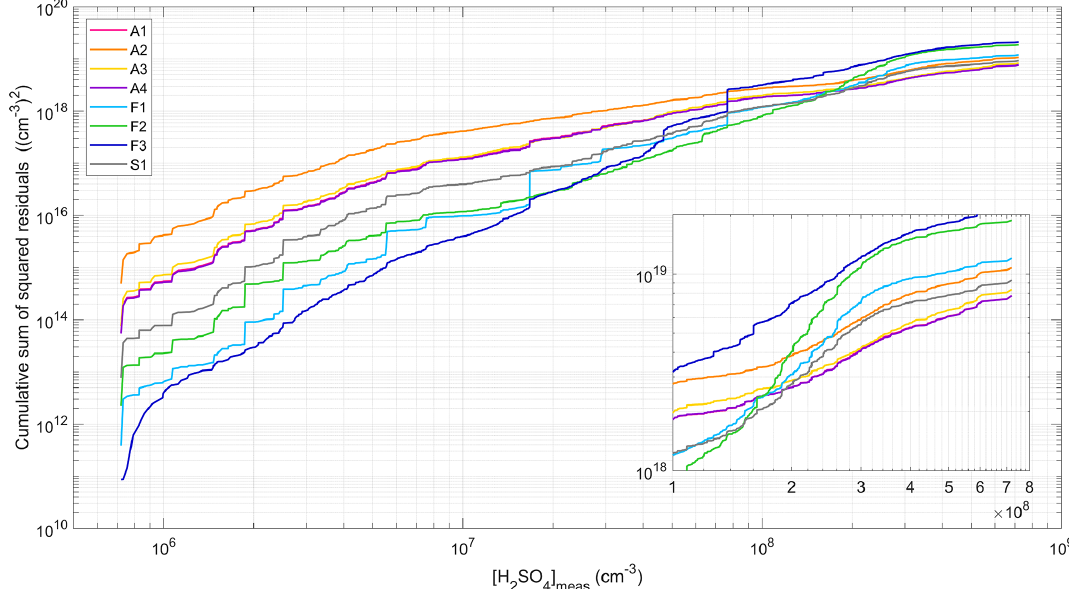
Figure 4. Cumulative sum of squared residuals associated with the different proxies. The insert presents a zoomed in section of the results obtained for [H 2 SO 4 ] > 1 × 10 8 cm − 3 .